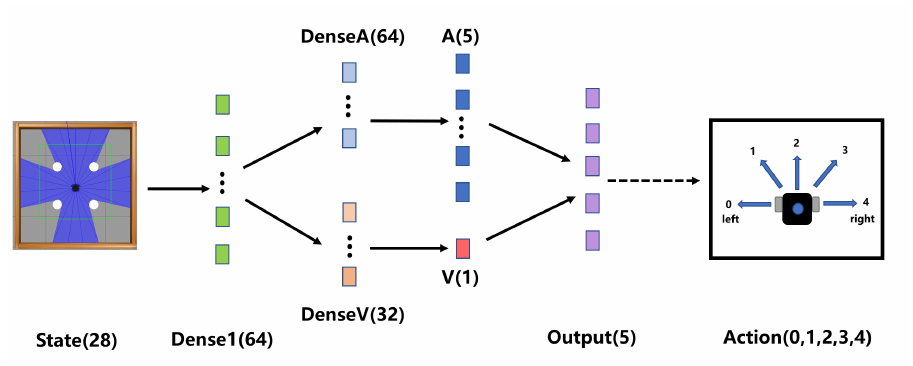
Figure 4. Network architecture diagram of RND3QN. The input layer is a state of size 28 dimensions and enters the branching fully connected layer after a fully connected layer of dimension size 64. The two branching fully connected layers of dimension size 64 and 32, DenseA and DenseV, are the advantage network and value network, respectively. The outputs of the two branching fully connected layers are calculated by Equation (13) to output the final Q value, and the action with the largest Q value is selected for